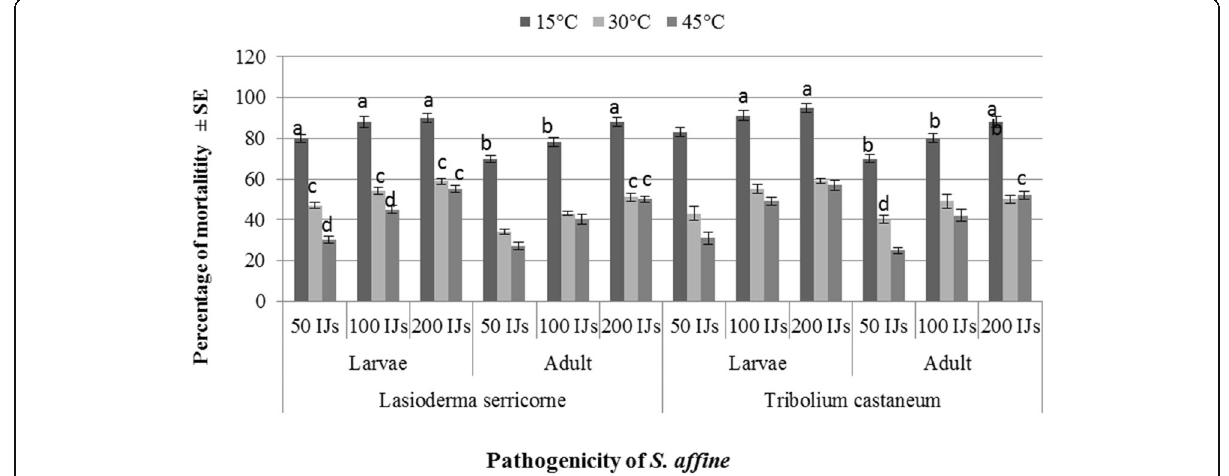
Fig. 2 Percentage mortality of insects at three different concentrations and temperatures inoculated by S.